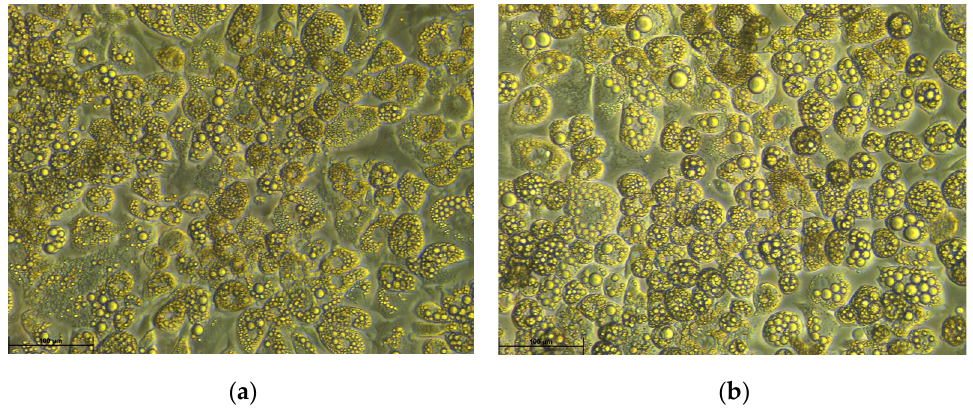
Figure 1. Phase-contrast microscopy images of control ( a ) and hypertrophic ( b ) 3T3-L1 cells on day 12 of adipogenic differentiation (100× magnification). Hypertrophy was induced by addition of palmitic acid (PA, 0.5 mM) to DMEM (+10% FBS) culture medium. 3T3-L1 cells were first subjected to differentiation in DMEM (+10% FBS) culture medium supplemented with 3-isobutyl-1- methylxanthine (IBMX, 0.5 mM), dexamethasone (DEX, 1 μ M), insulin (0.5 μ M), and rosiglitazone (2 μ M) for 3 days, followed by 3 day culture in DMEM (+10% FBS ) culture medium comprising insulin (0.5 μ M) and rosiglitazone (2 μ M). PA (0.5 mM) was administered to 3T3-L1 adipocytes from day 8 to day 12 of differentiation. Enlarged lipid droplets in adipocytes presented on image ( b ) are a characteristic feature of hypertrophy.